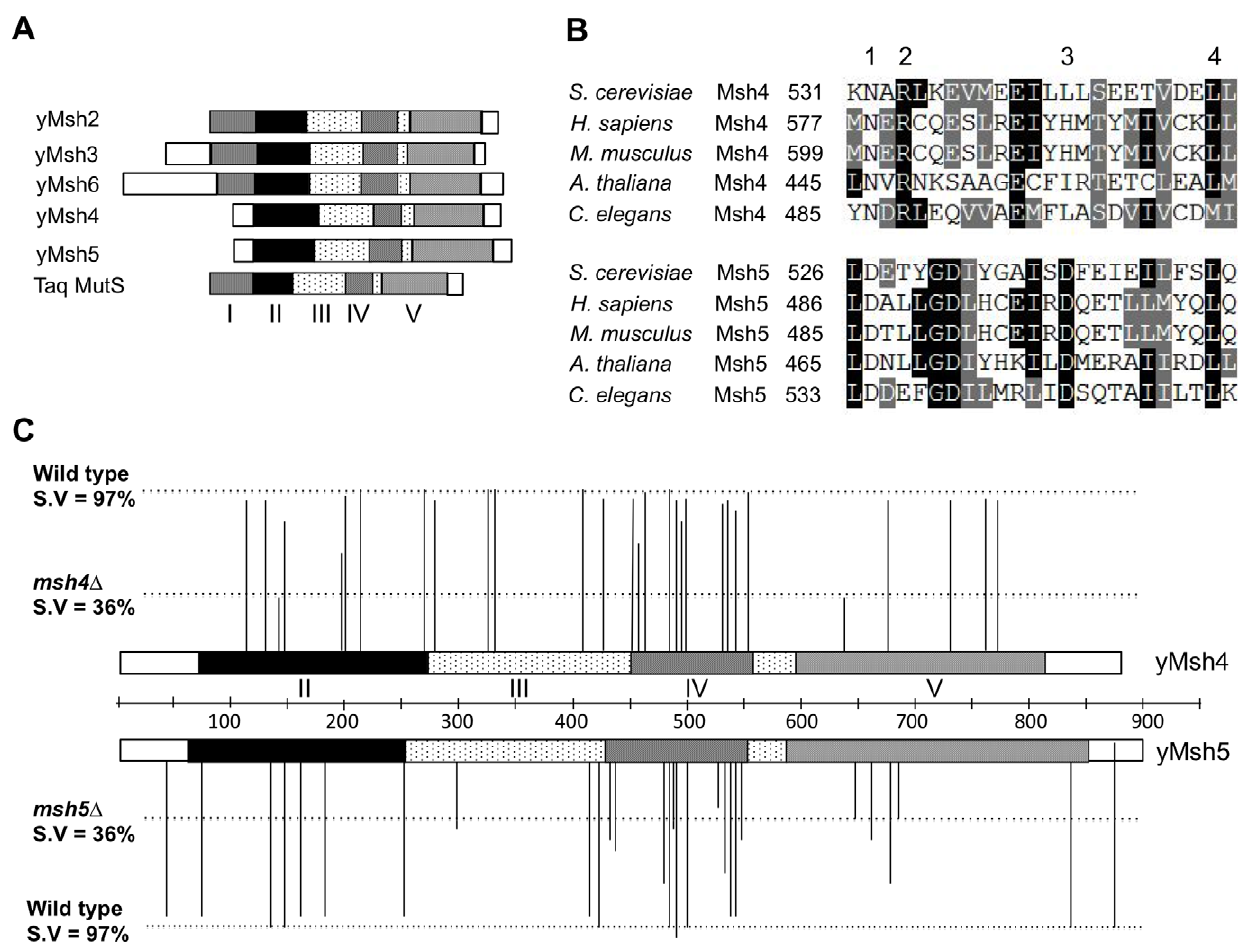
Figure 1. Structure-function analysis of msh4 , msh5 alleles. (A) Comparison of domain organization of yeast Msh proteins with the Thermus aquaticus ( Taq ) MutS protein. The five domains (I–V) identified in yeast Msh proteins based on structural homology to Taq MutS are shown to scale [35]. (B) Sequence alignment of Msh4 protein sequences from S. cerevisiae (YFL003C), H. sapiens (NM_002440), M. musculus (BC145838), A. thaliana (NM_117842) and C. elegans (AF178755) and Msh5 protein sequences from S. cerevisiae (YDL154W), H. sapiens (BC002498), M. musculus (NM_013600), A. thaliana (EF471448) and C. elegans (NM_070130). Representative residues from four different classes used for structure-function analysis are shown; Class 1 (Msh4, Msh5 specific); Class 2 (Msh4 specific); Class 3 (Msh5 specific) and Class 4 (Msh family specific). (C) Spore viability profiles of 57 msh4 , msh5 mutations in the EAY background are shown with reference to the domain organization of the Msh4, Msh5 proteins. The height of each line corresponds to the spore viability of each mutant relative to wild-type and null. Four domains (II–V) in the Msh4, Msh5 proteins based on structural homology to MutS are shown [35].